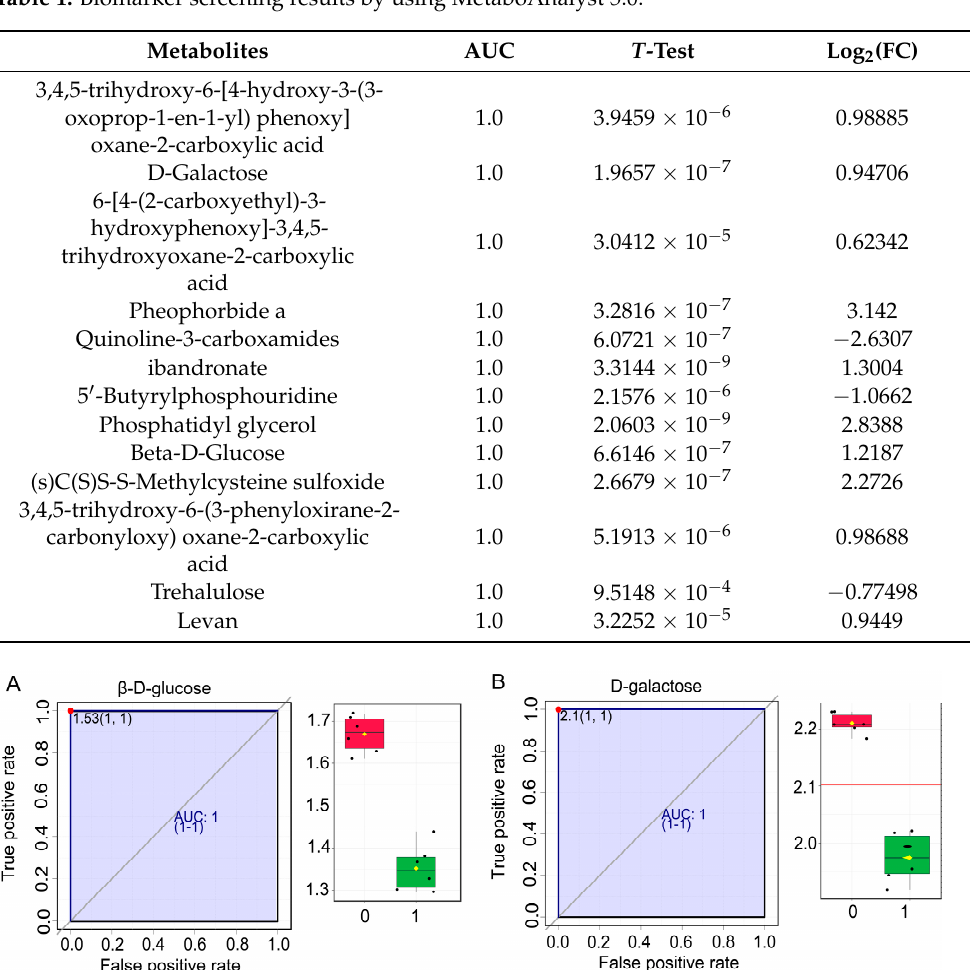
Table 1. Biomarker screening results by using MetaboAnalyst 5.0.